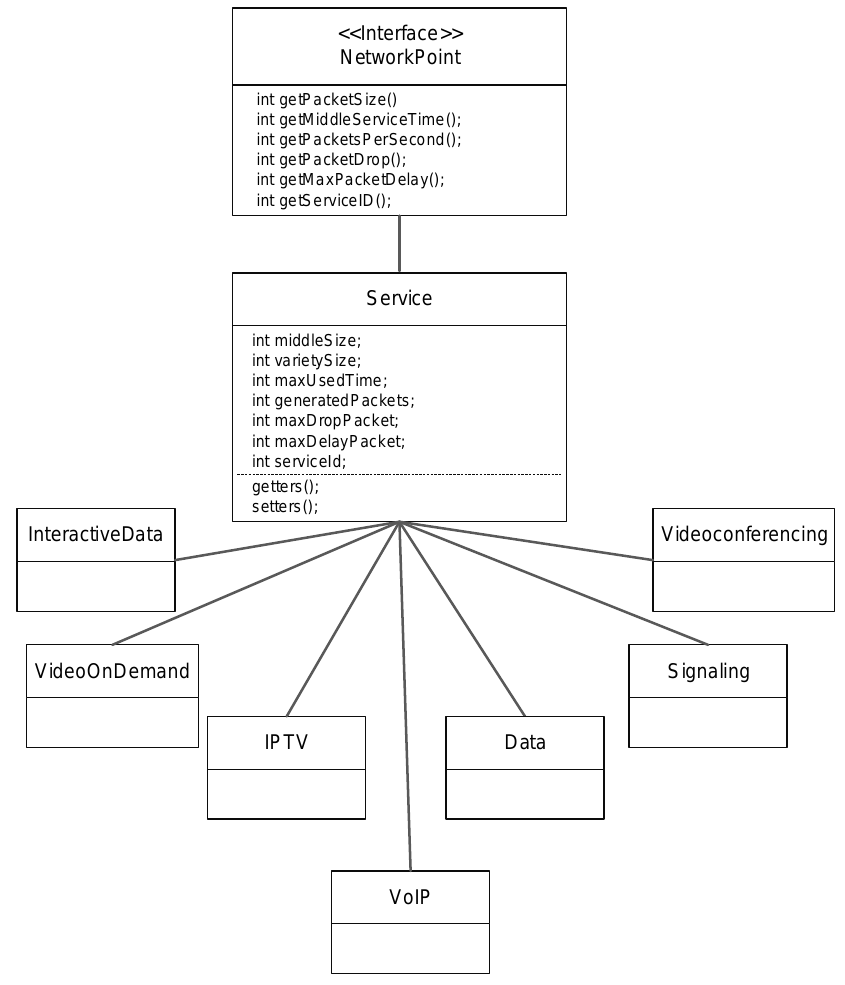
Figure 10. The UML diagram for types of services in the network.